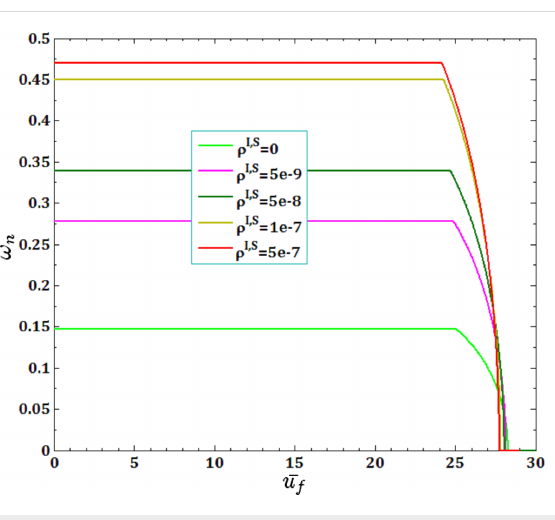
Figure 13: The effect of surface ρ S and interface ρ I mass density for fluid velocity on DNF of SS